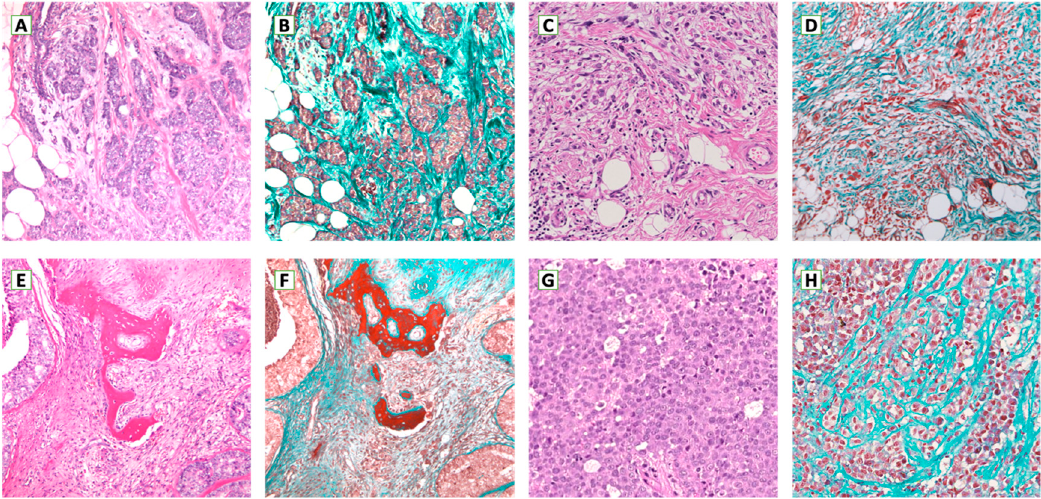
Figure 1. Tumor stroma in primary ( A – D ) and metastatic breast cancer (( E , F ): bone; ( G , H ): brain) ( A , C , E , G : H & E 100 × magnification; B , D , F : Masson’s Tricrome 100 × magnification; H : Masson’s Tricrome 200 ×